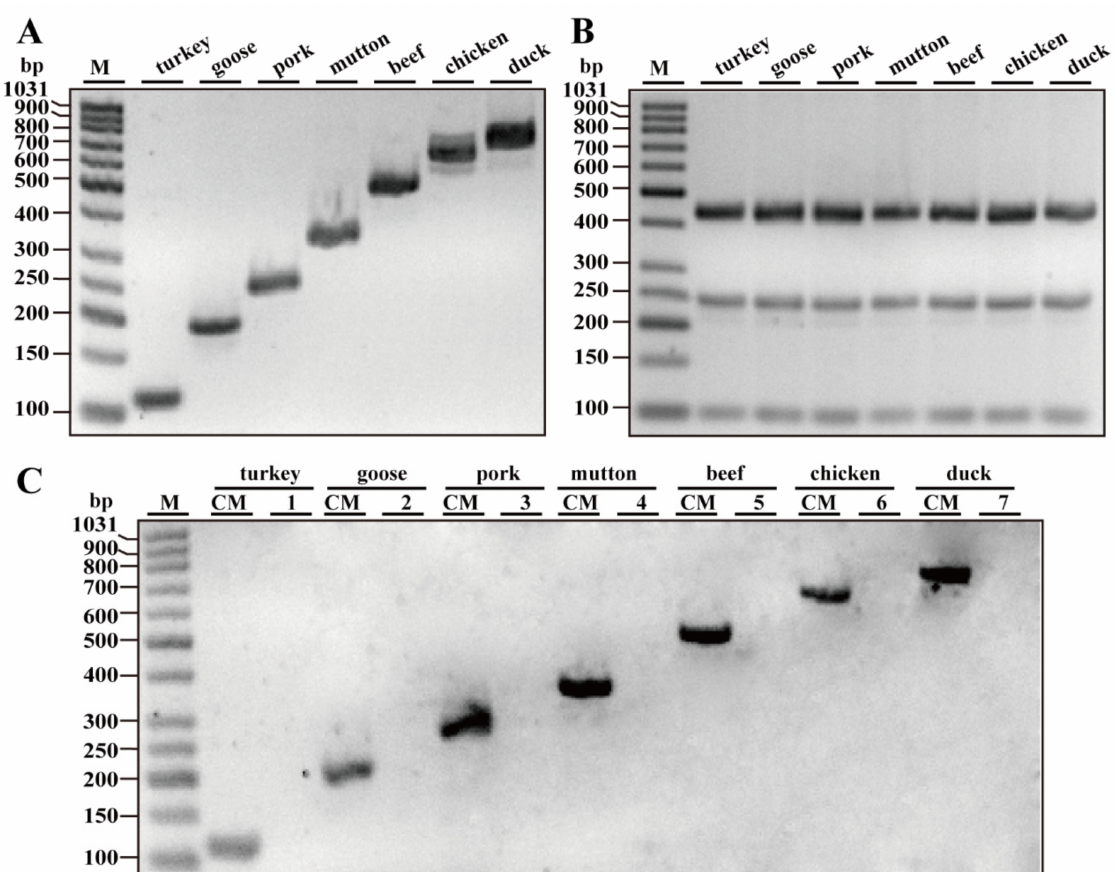
Figure 1. Specificity assays of simplex PCR. ( A ) Gel image of the products generated by PCR amplification with species- specific primers for turkey, goose, pig, cattle, sheep, chicken and duck using corresponding genomic DNA as a template, respectively. ( B ) As positive controls, gel image of the PCR products generated after amplification with premixed universal eukaryotic primer pairs of 12S rRNA, 16S rRNA and 18S rRNA genes for all meat species. ( C ) Gel image of the products through simplex PCR amplification using species-specific primers for turkey, goose, pig, cattle, sheep, chicken and duck. CM, a complete mixture of turkey, goose, pig, cattle, sheep, chicken and duck; 1–7, a complete DNA mixture except target species DNA. Lane M is ladder